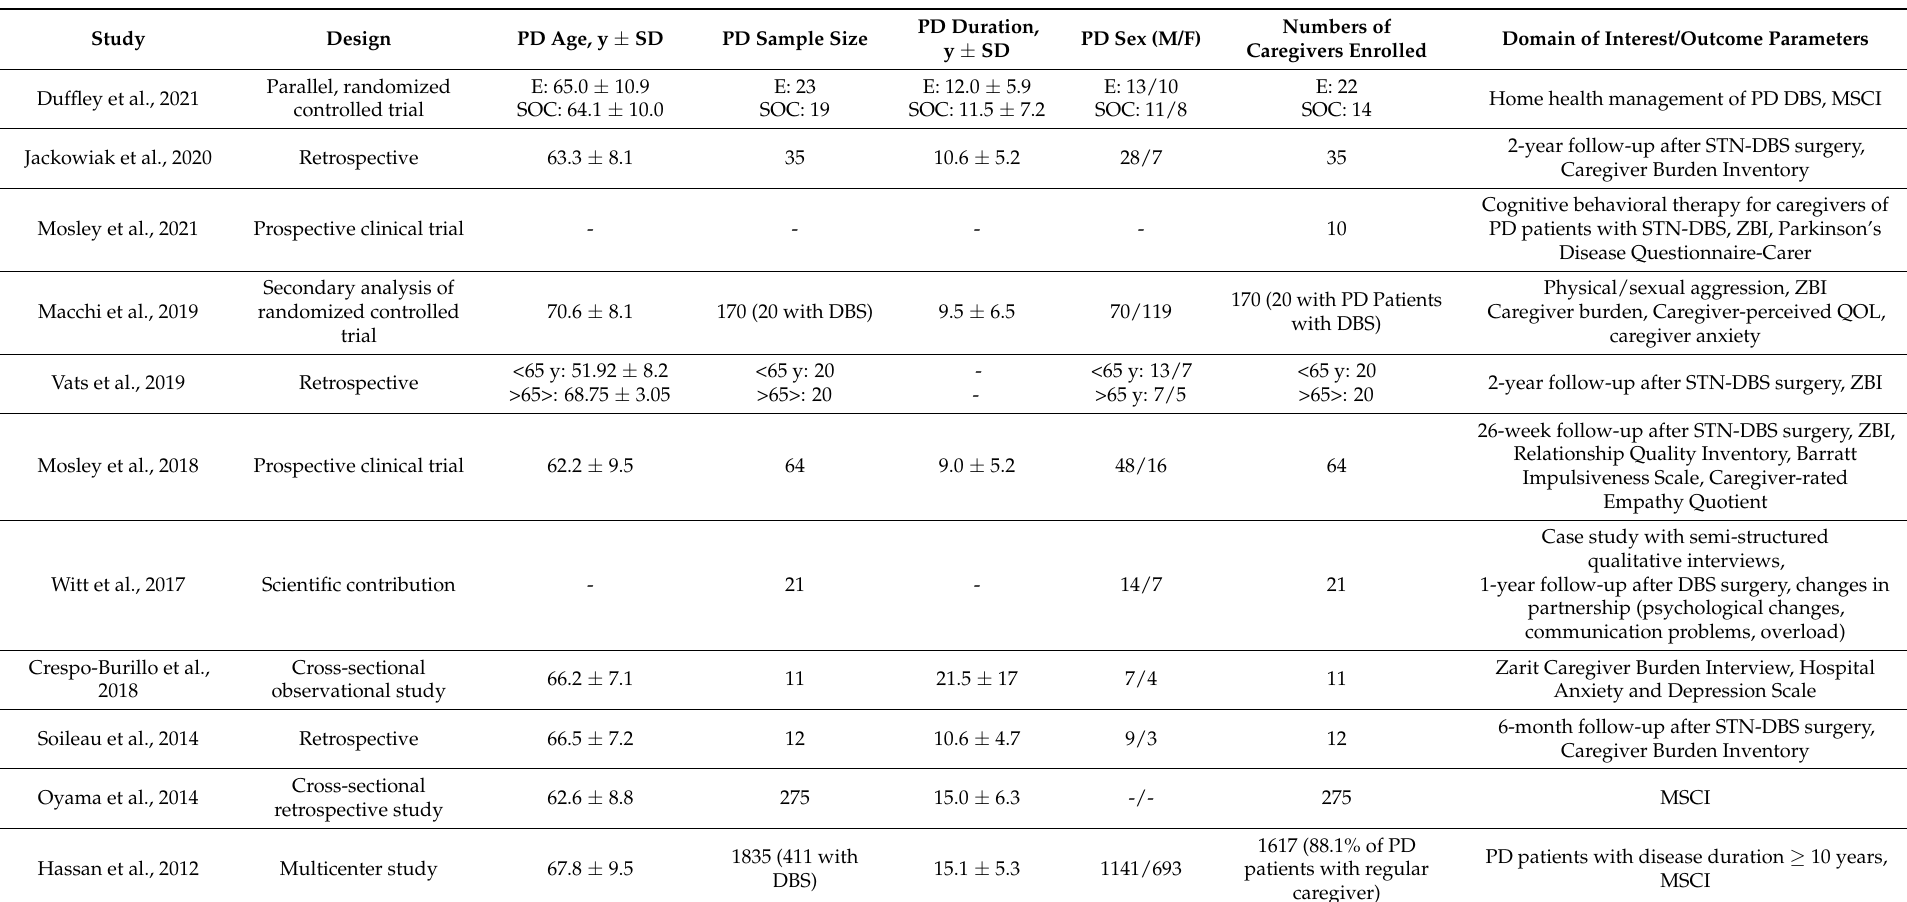
Table 1. Overview of included studies on caregiver burden in DBS PD patients. Studies were identified in PubMed with the search terms “Caregiver Burden” and “Deep Brain Stimulation” or “DBS”. C: Control group; DBS, Deep brain stimulation; E: Experimental group; MSCI; Multidimensional Caregiver Strain Index; PD, Parkinson’s disease; QOL, Quality of life; SD, Standard deviation; y, years; ZBI, Zarit burden